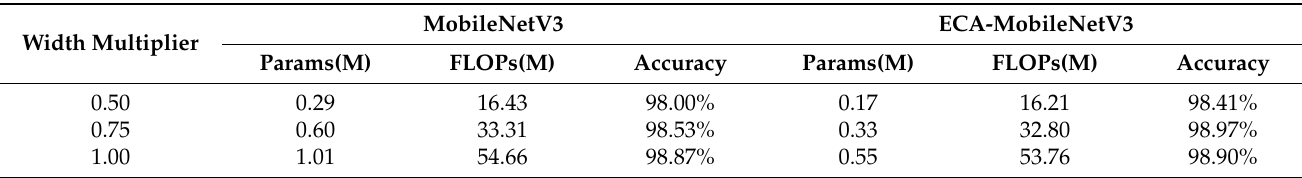
Table 6. Algorithmic complexity comparison for different-width multipliers on Shanghai Hongqiao Airport dataset.